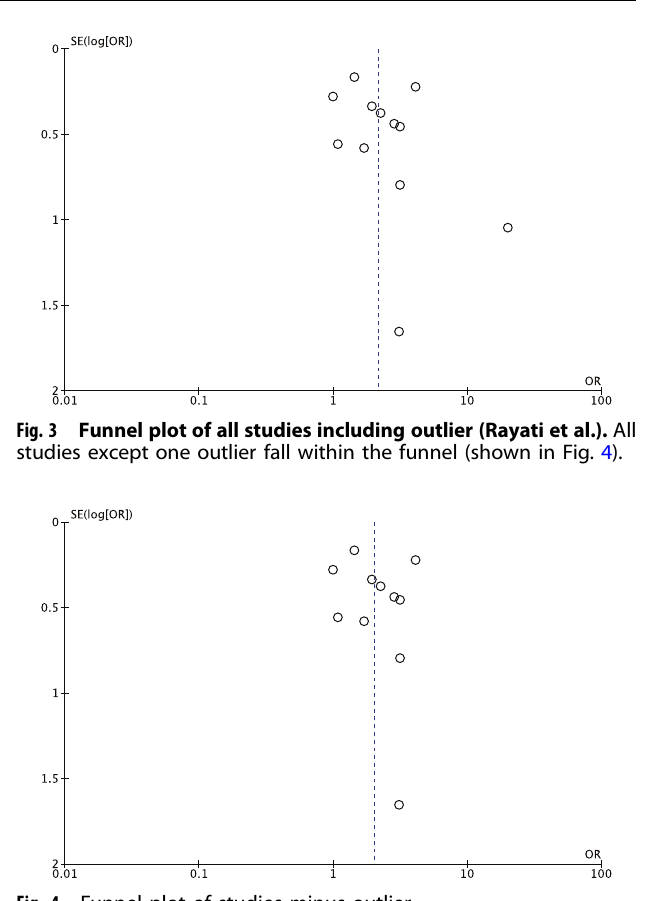
Fig. 4 Funnel plot of studies minus 1.89 times likelihood of anaesthetic success of lidocaine. The results were signi fi cant ( P = 0.02) (Fig. 11). For all asymptomatic teeth in the meta-analysis (OR: 2.51, 95% CI: 1.47, 4.34, I 2 = 73%), articaine had 2.51 times likelihood of anaesthetic success of lidocaine. The results were signi fi cant ( P = 0.001) (Fig. 12).